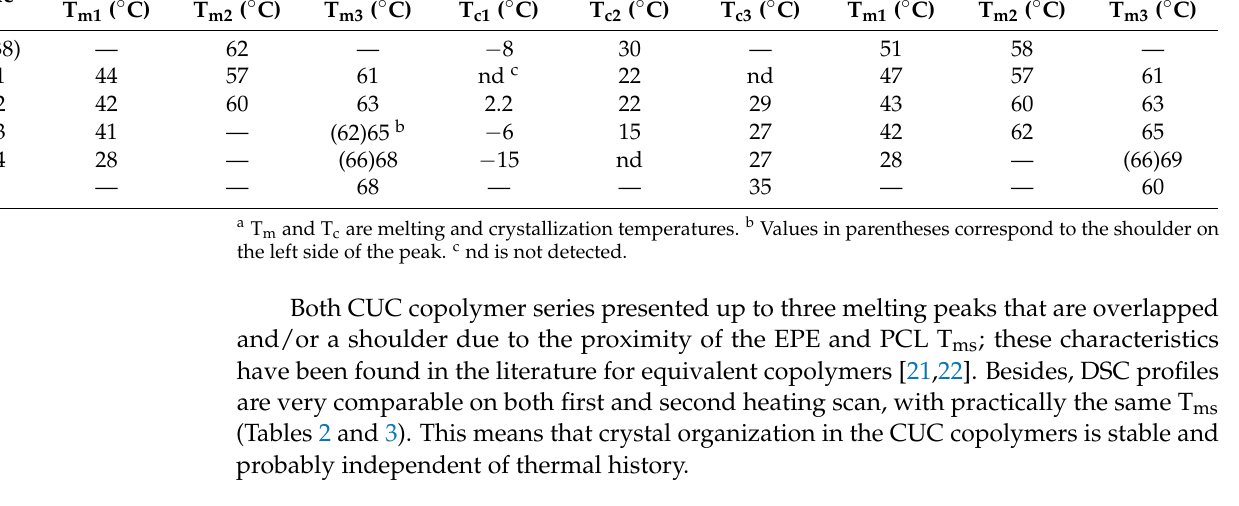
Table 3. Thermodynamic parameters of CUC5–CUC8 series a .